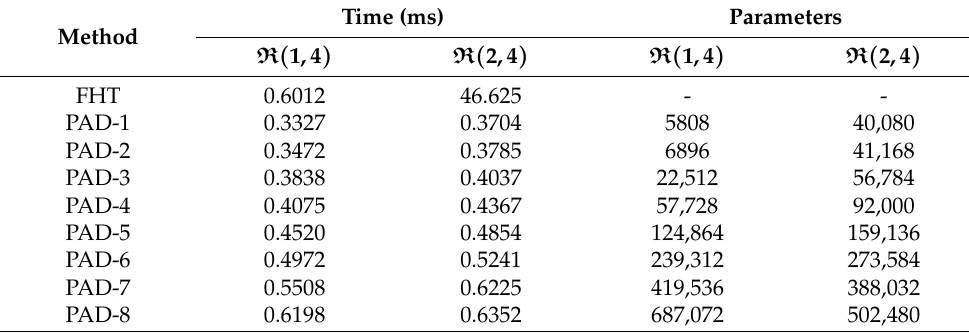
Table 7. RM decoding time using FHT and